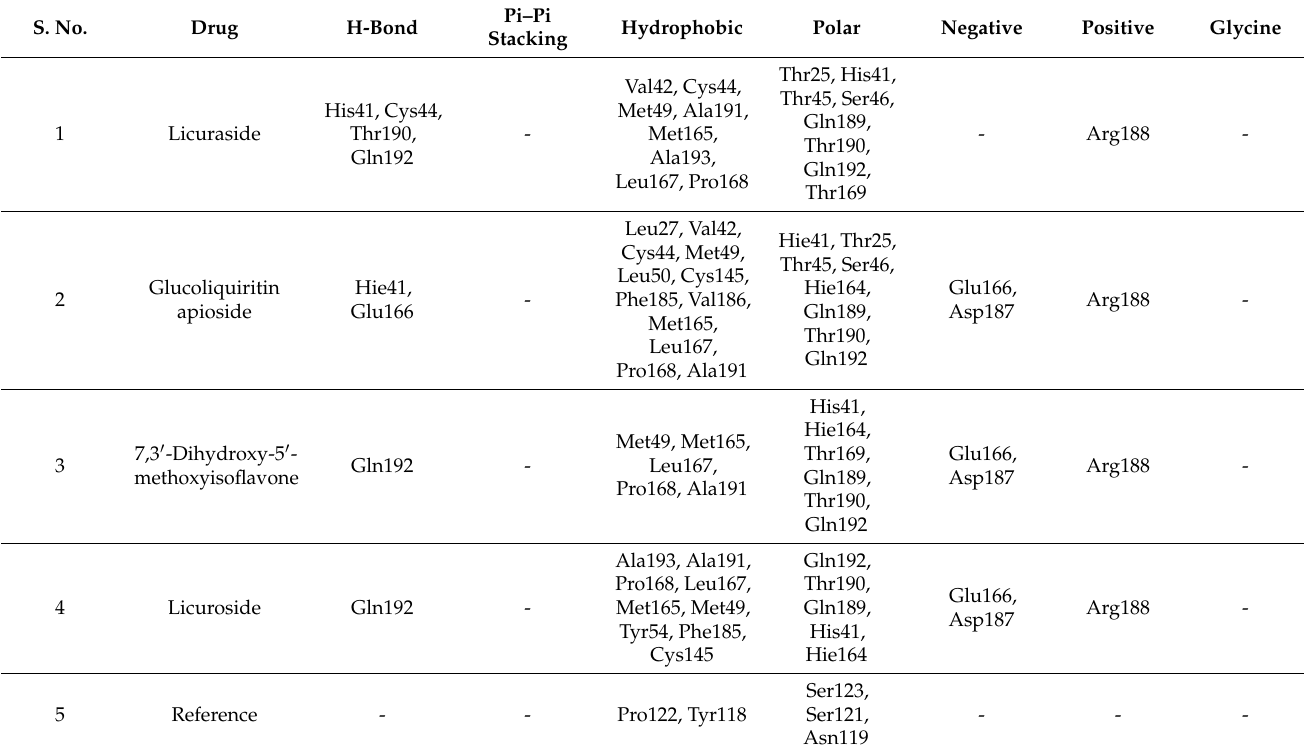
Table 2. Analysis of molecular contacts in the last poses of each protein-ligand complex after MD simulation. S.